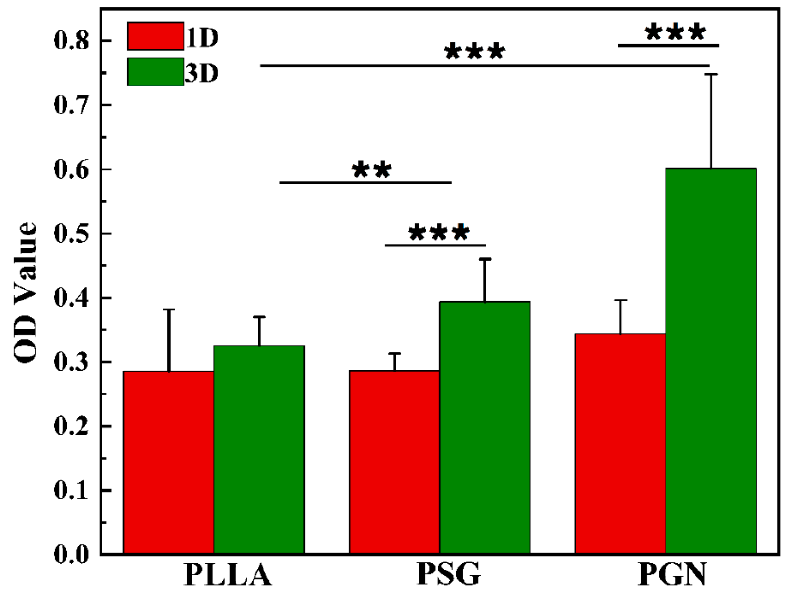
Figure 8. Cell viability measured with CCK-8 assay on PLLA, PSG and PGN nanocomposites monolayer film at different culture times (** p < 0.01, *** p < 0.001).